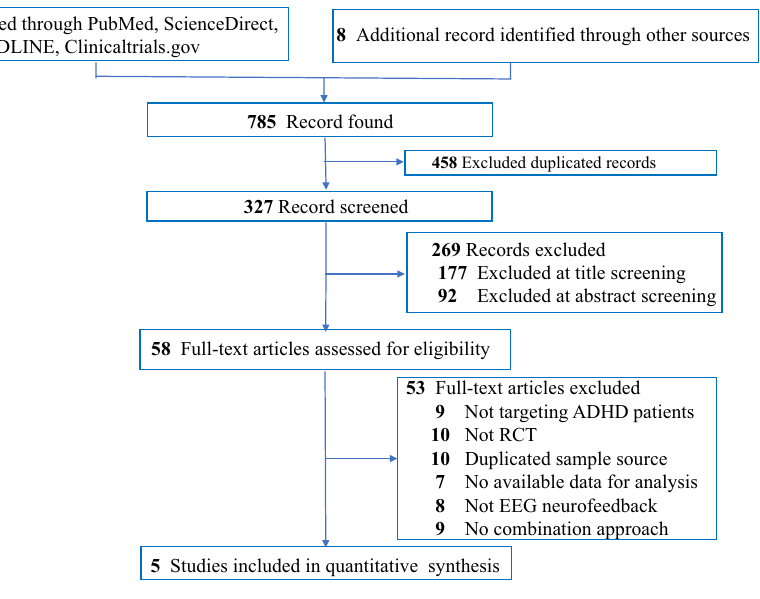
Figure 1. PRISMA diagram of identifying eligible